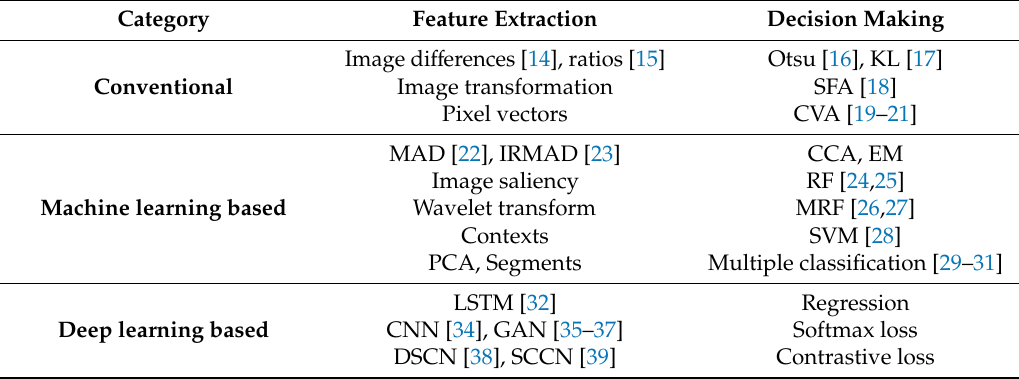
Table 1. Feature extraction methods and decision making algorithms for change